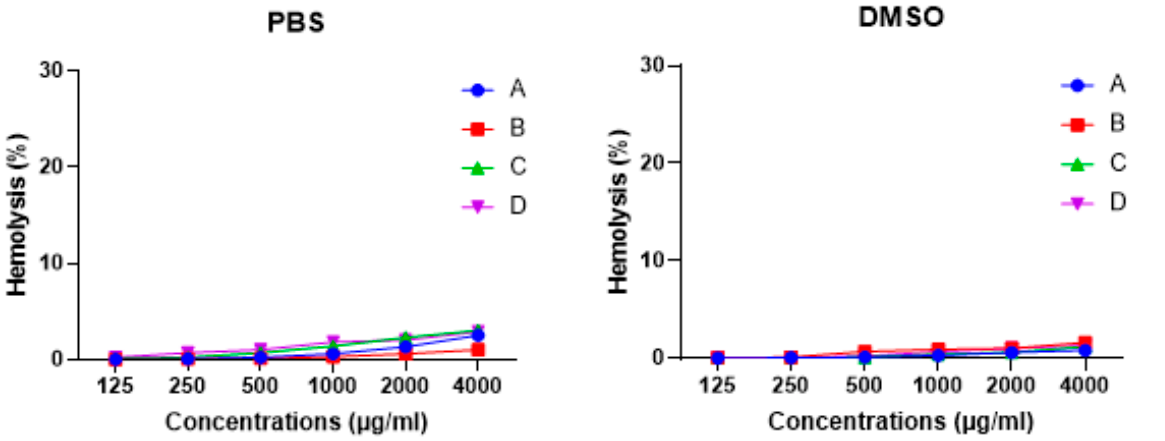
Figure 7. Hemolytic activity of honey bee hemolymph extracted in PBS or DMSO at different con- centrations against erythrocytes where ( A ): bees from Port Said, ( B ): bees from Ismailia governorate, ( C ): bees from Suez governorate, ( D ): bees from Saint Catherine.